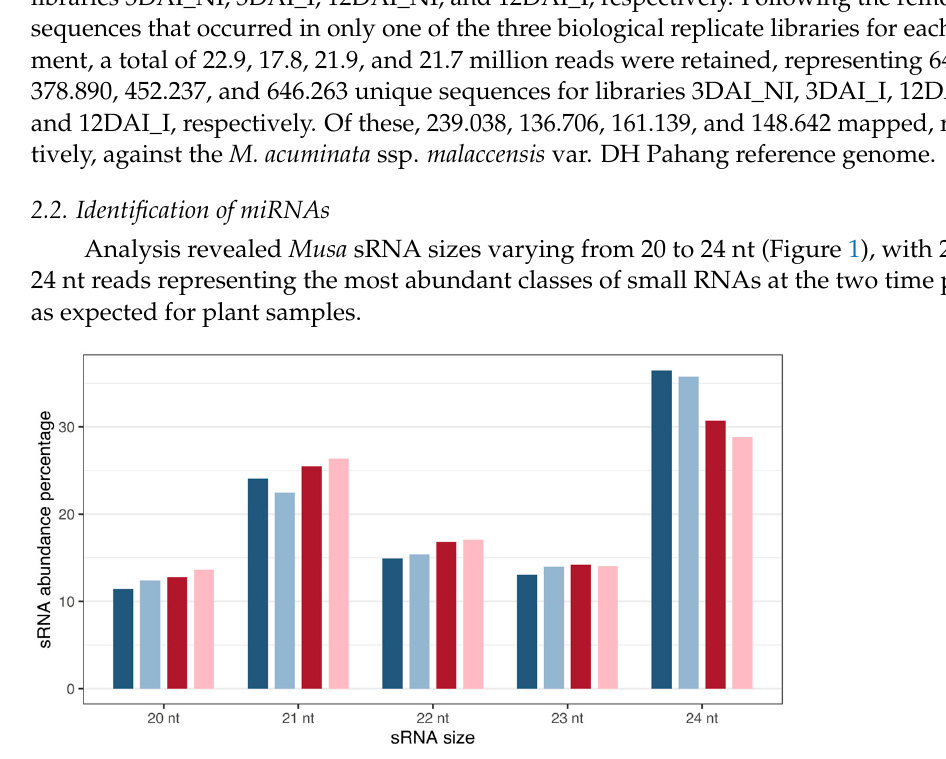
Figure 1. Size distribution and percentage abundance of M. acuminata var. Calcutta 4 small RNA sequences. Blues: 3DAI. Reds: 12DAI. Dark-coloured bars: non-inoculated samples; light-coloured bars: inoculated samples. Abbreviation: nt, nucleotides.